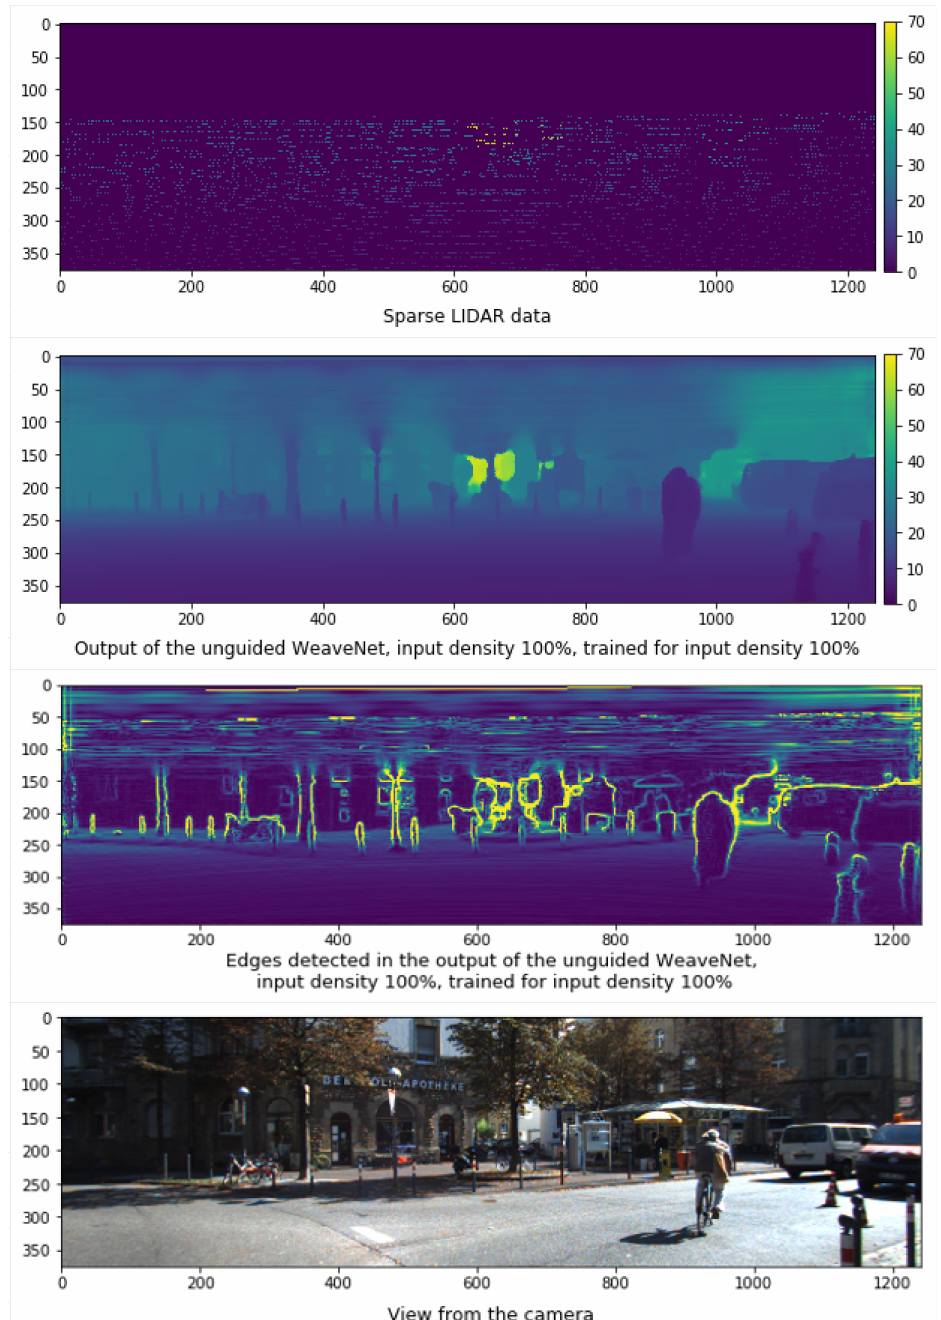
Figure 2. Output of the unguided WeaveNet together with the sparse LIDAR data and corresponding camera image. The edges in the output of the network are shown to demonstrate the capability of network to accurately represent fine details. The same frame is used as the basis of all future images in this